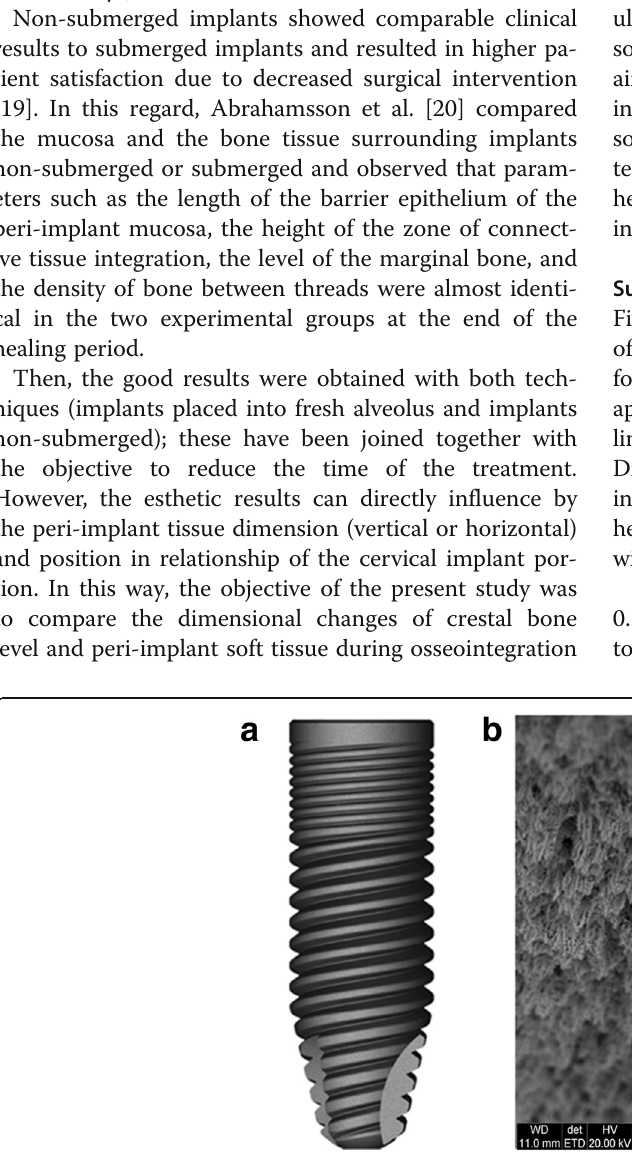
Fig. 1 Image of the implant ( a ) and surface ( b ) used in the present